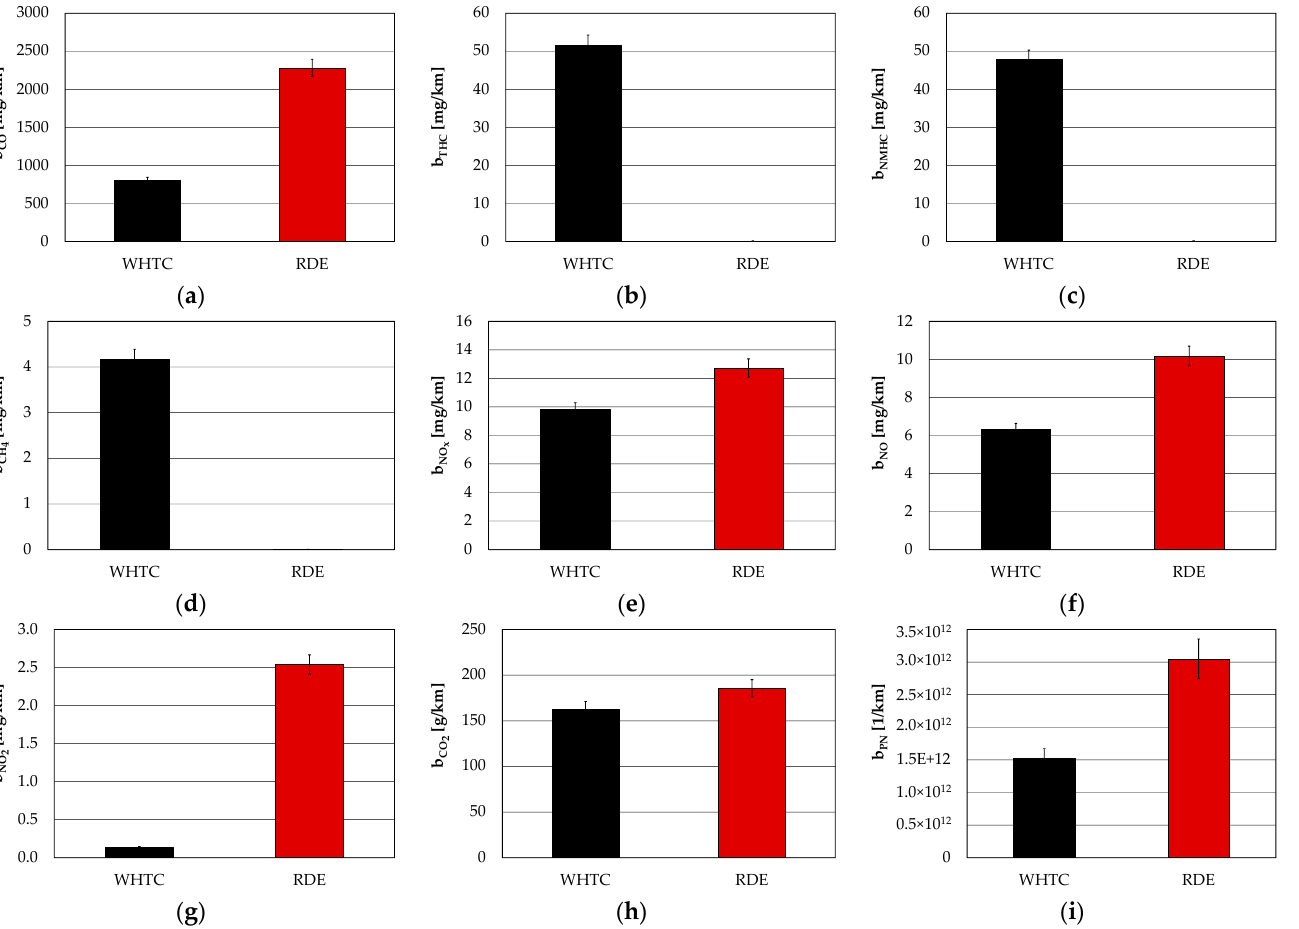
Figure 4. Comparison of mean road exhaust emissions in the different phases of the RDE and WLTC tests for: ( a ) carbon monoxide; ( b ) hydrocarbons; ( c ) non-methane hydrocarbons; ( d ) methane; ( e ) nitrogen oxides; ( f ) nitrogen oxide; ( g ) nitrogen dioxide; ( h ) carbon dioxide; ( i ) number of emitted particles.